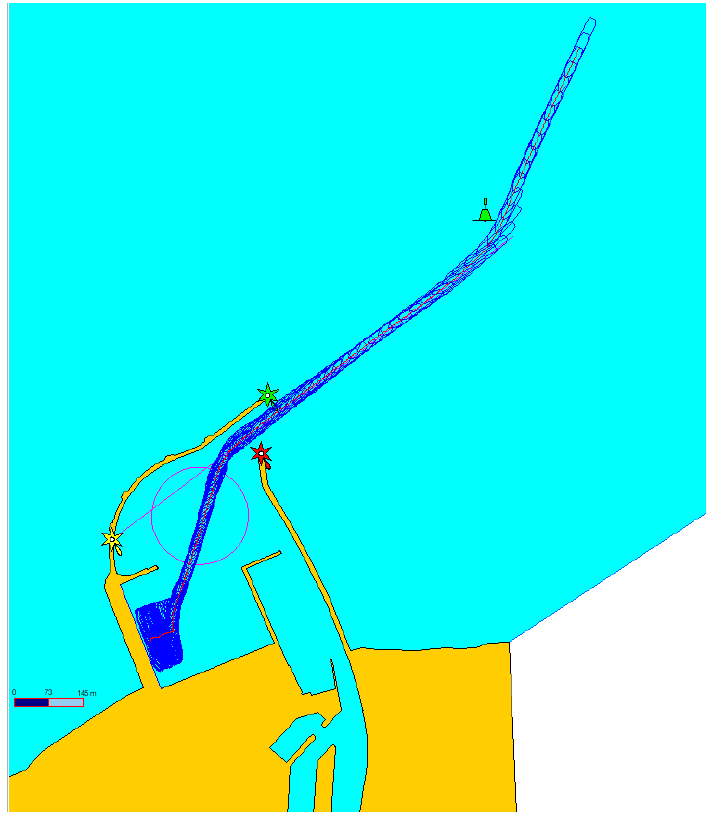
Figure 11. The single simulation passage—entrance and berthing in zero wind conditions.